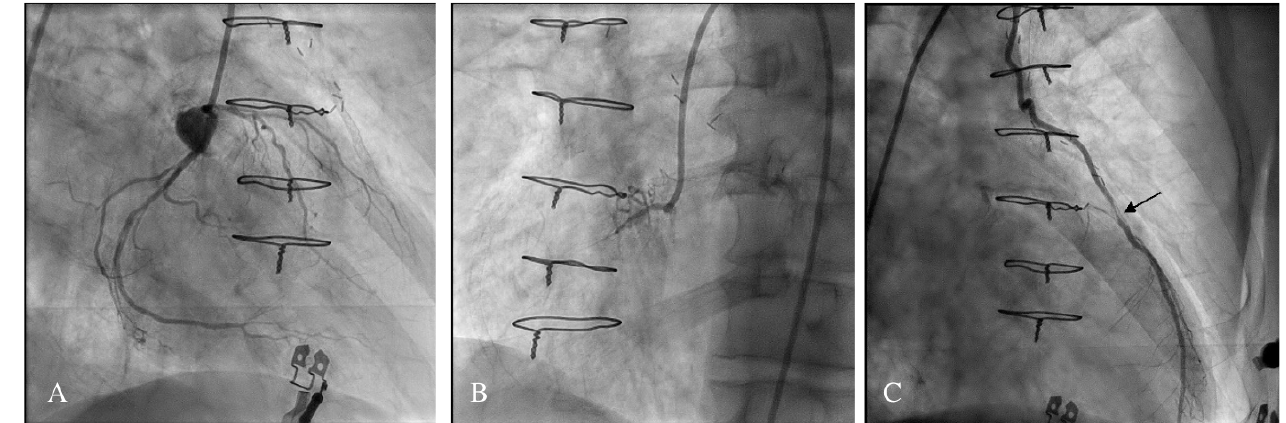
Fig. 2 – (A) Preoperative coronary angiography, right coronary. (B) Preoperative coronary angiography, left coronary. (C) Preoperative coronary angiography, LITA to LAD. Note the tight stenosis at the anastomotic site